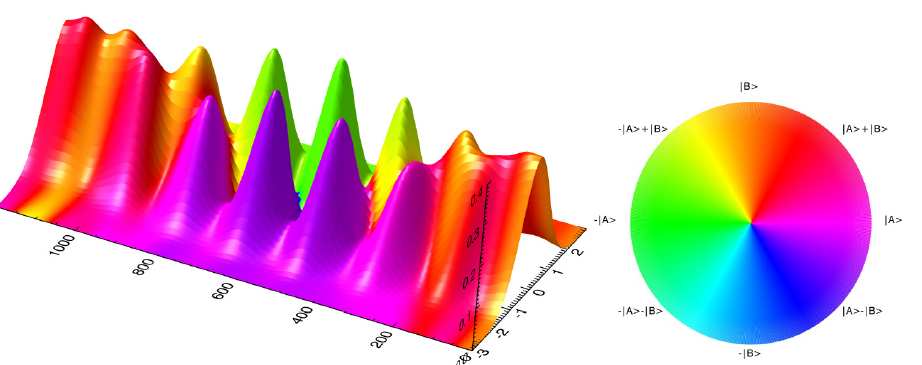
Fig. 1. Left) Vibrational probability density as a function of the anticorrelated coordinate and B time over 1200 fs. Color indicates the electronic character through the color wheel (right). Here, the donor pigment is excited at